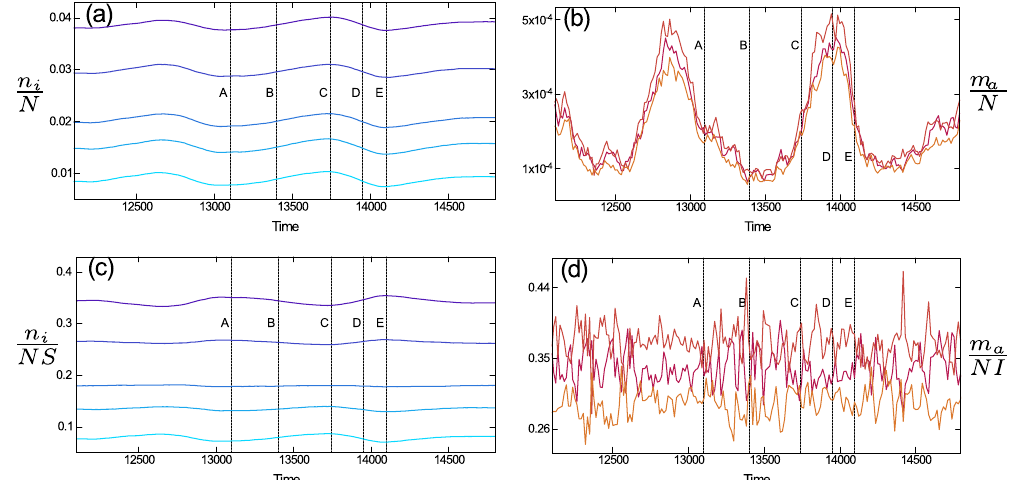
Figure 7. Stochastic cycles in subgroups of susceptibles and infectives. We show the same simulation run as in Fig. 2, but now split up into the different subgroups. Panels (a) and (b) show the number of individuals in each susceptible and infective subgroup normalised by the total population ( N ). In panels (c) and (d), we show the number of individuals in each subgroup divided by the total number of susceptible or infected individuals, respectively ( NS and NI ). Lines labelled A to E refer to points in the cycles of the aggregate variables S , I shown in Fig. 2.